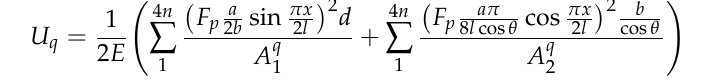
: the vertical load on the tower F P